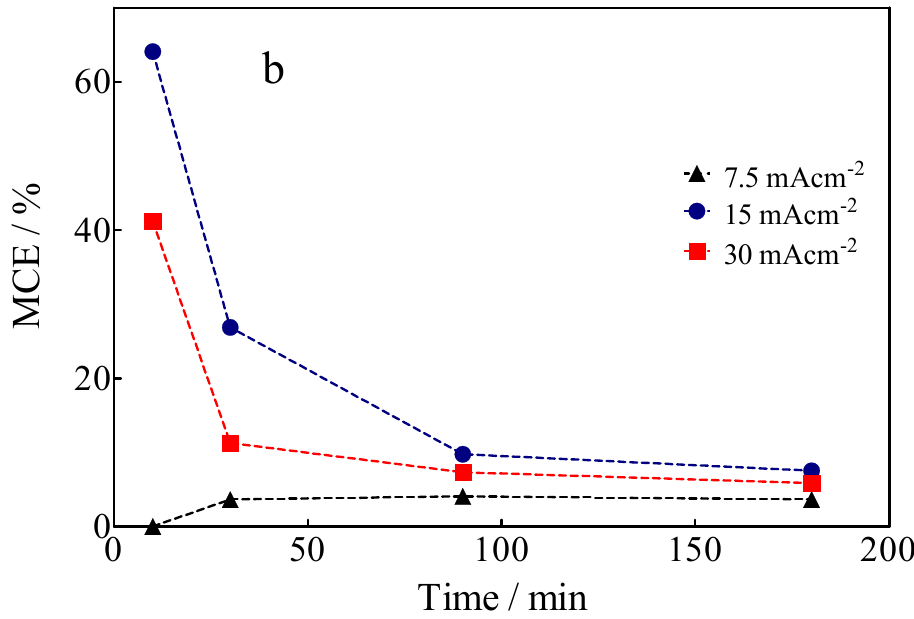
Figure 8. ( a ) Variation of TOC as a function of the electrolysis time and applied current density for the EO of Calcon dye at the BDD anode in 0.25 M H 2 SO 4 . ( b ) MCE for Calcon dye as estimated from the values of TOC measured for the electrolysis process.